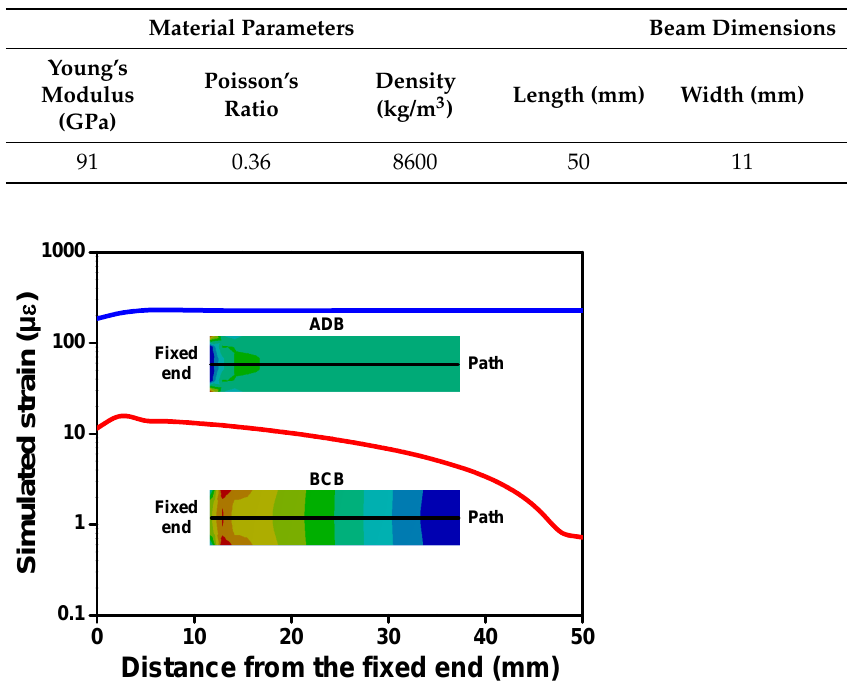
Figure 3. Simulated stress distributions on the top surface of ADB and BCB.